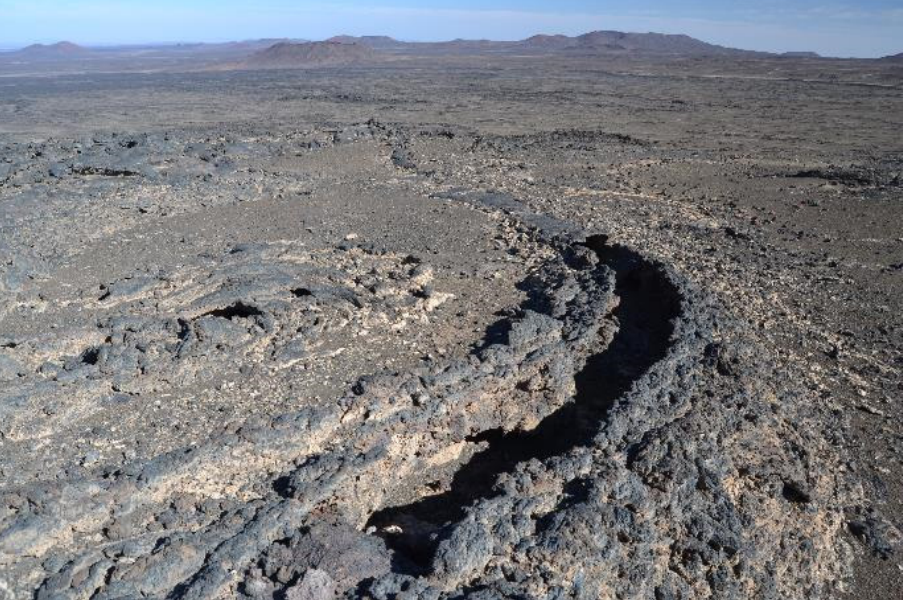
Figure 11. Narrow, partially unroofed flow channel at the foot of a lava spatter cone. The channel is about 2 m wide.